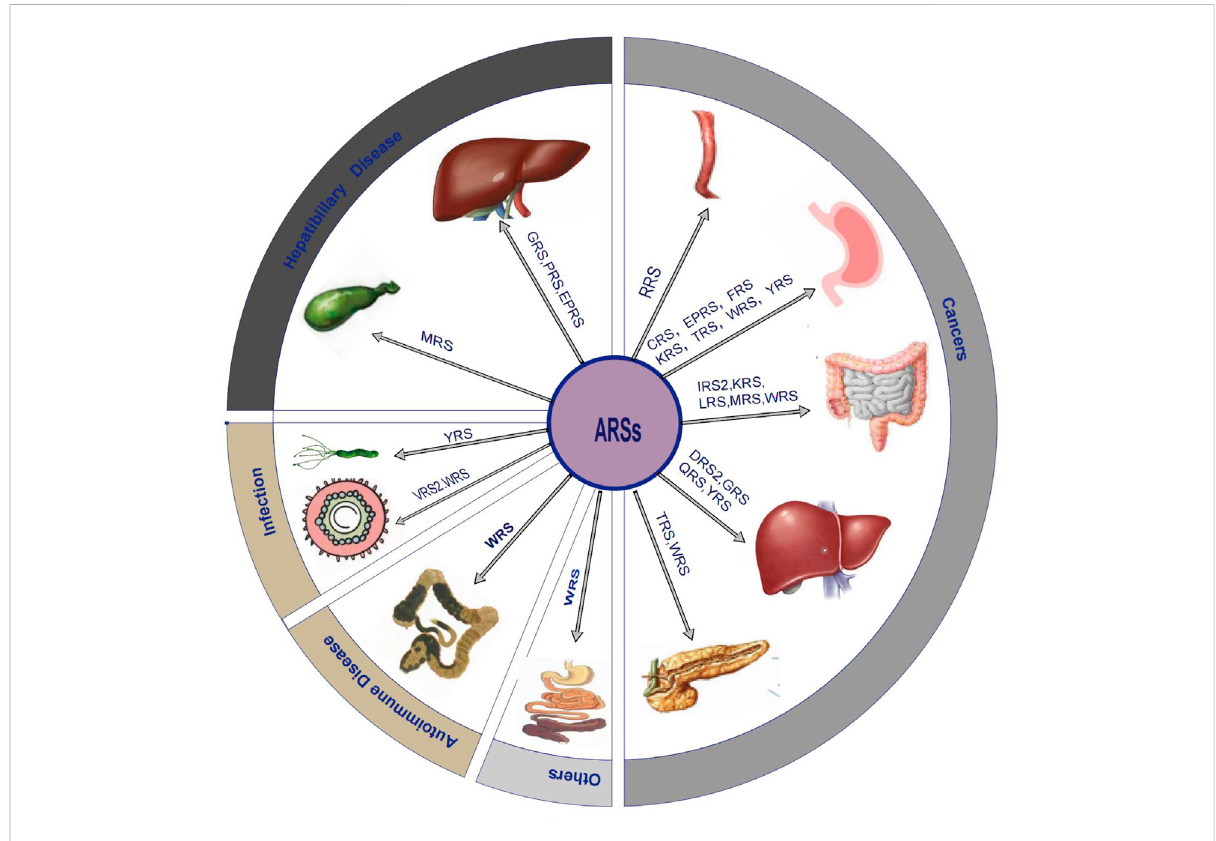
FIGURE 1 Overview diagram that shows ARSs related digestive system